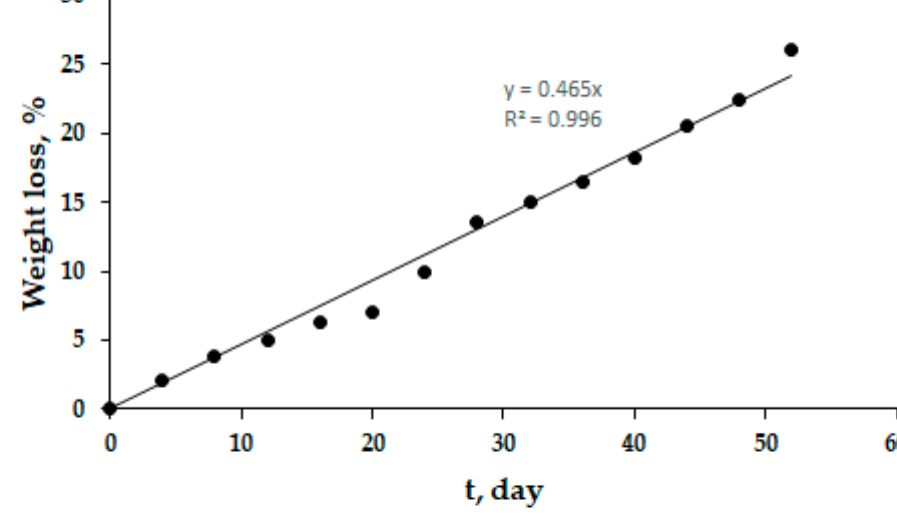
Figure 9. Weight loss of the terpolymer in soil.